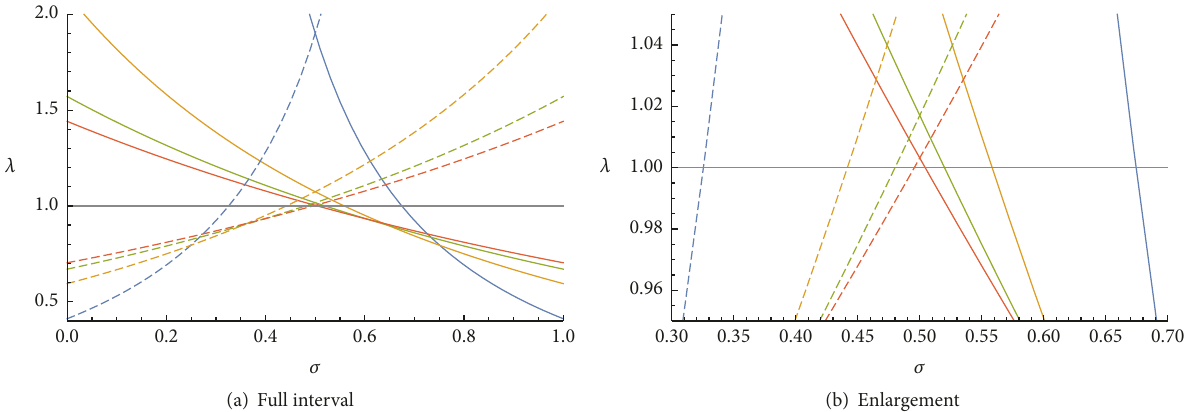
Figure 5: Solutions for 𝜆 (see (61)) (solid lines) for different values of 𝜌 ∗ . Dashed lines show reflection in 𝜎 = 1/2 to show the effect of reversing the switching order of the groups. Blue: 𝜌 ∗ = 0.1 , yellow: 𝜌 ∗ = 0.2 , green: 𝜌 ∗ = 0.3 , and red: 𝜌 ∗ = 0.4 . Black line shows the boundary of stability (stable below, unstable above). The results are identical when 𝜌 ∗ is replaced by 1−𝜌 ∗ . (b) shows an enlargement centred at 𝜎 = 1/2 , showing that either switching order of the groups leads to 𝜆 2 > 1 on a small interval of 𝜎 . In this case the groups never merge and in all other cases they